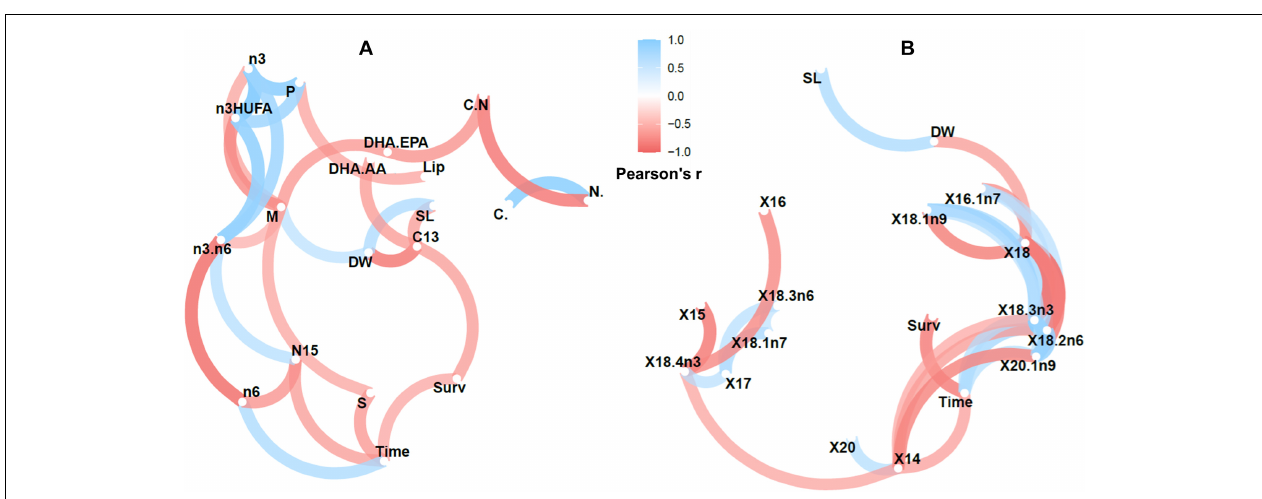
FIGURE 3 | Correlation network plots for newborn seahorses (Diet AM) showing the more highly correlated variables (Pearson’s r > 0.6), which appear closer together and joined by stronger paths. Paths are also colored by their sign (blue for positive and red for negative). The proximity of the points were determined using multidimensional clustering. Original variable names were modified by R software. Variables: (A) time (days elapsed since the onset of the breeding period), SL, W, Survival at 7 DAR (Surv), total C (C.), total N (N.), C/N, δ 13 C (C13), δ 15 N (N15), total lipids (Lip.DW), saturated FA (S), monounsaturated FA (M), polyunsaturated FA (P), n-3 HUFA, n-3 FA, n-6 FA, n-3/n-6 (n3.n6), DHA/EPA (DHA.EPA) and DHA/AA (DHA.AA); (B) time, SL, W, Survival at 7 DAR (Surv) and individual